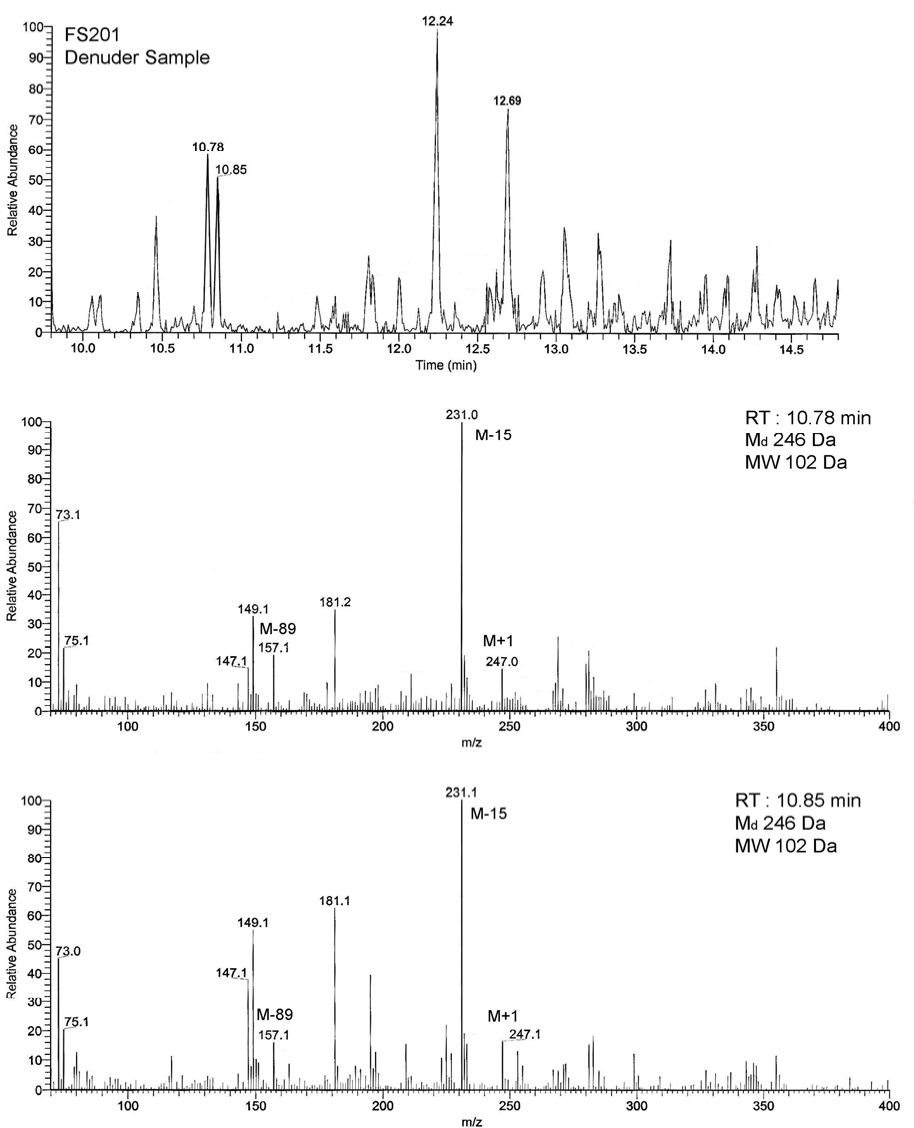
details and terminology used for the figure are the same as that in Edney et al. (2003).